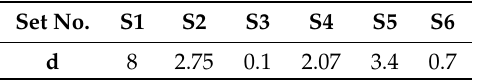
Table 7. Statistical